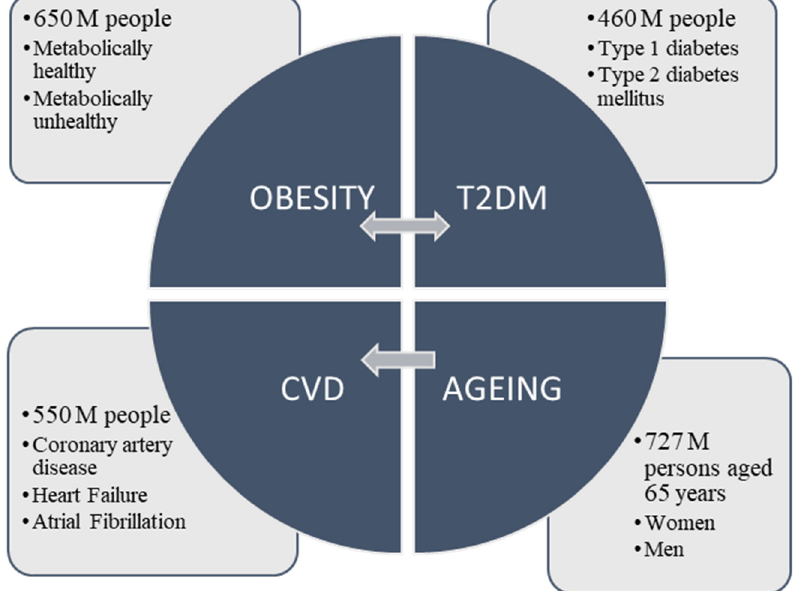
Figure 1. Prevalence of obesity, type 2 diabetes mellitus (T2DM), cardiovascular disease (CVD) and ageing.